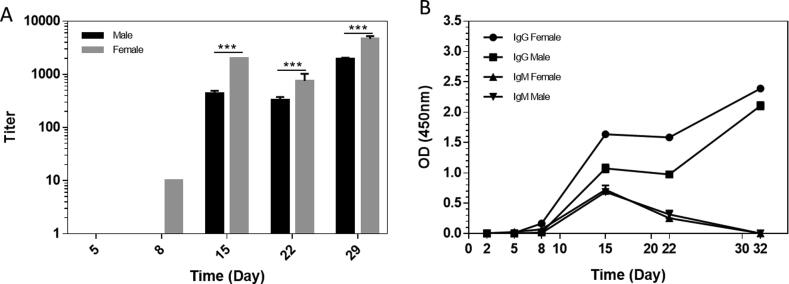
Anti-SARS-CoV-2 S1 antibody levels in S1-Fc immunized macaques. A) The ELISA titers of total anti-S1 antibodies in macaque sera. Sera were evaluated by ELISA using HRP-conjugated goat-anti-human IgG (H + L) secondary antibodies (P < 0.001, one-way Anova; n = 4). The horizontal coordinate is time and the vertical coordinate is the ELISA titer of anti-S1 antibodies in the sera. B) The levels of IgG and IgM in macaque sera. Sera were diluted 50 times with normal monkey serum and then diluted 20 times with sample dilution buffer. The samples were examined with either HRP-conjugated goat anti human IgG Fc-specific secondary antibodies (1:20000) or HRP-conjugated mouse monoclonal anti-μ-Chain of human IgM (1:5000). The horizontal coordinate is time and the vertical coordinate is absorbance value at 450 nm.